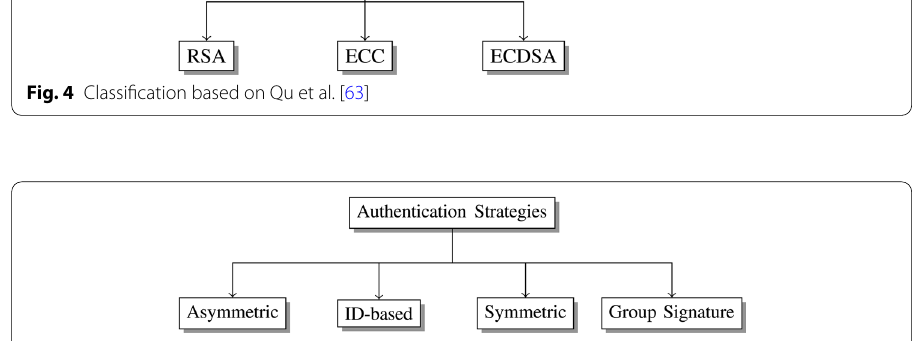
Fig. 5 Classification based on Petit et al.